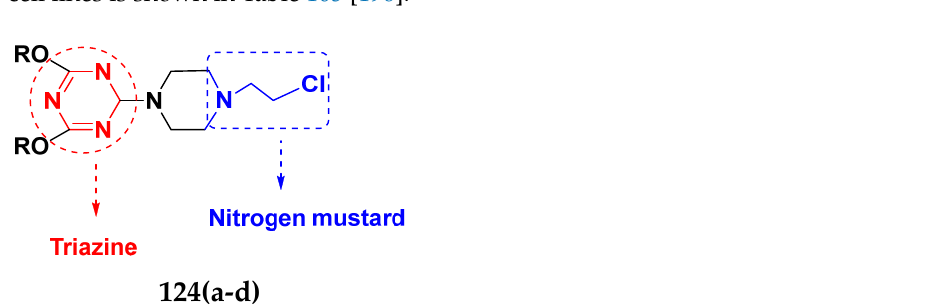
Figure 118. Structure of nitrogen mustard ‐ containing triazine derivatives 124 ( a – d ). Table 105. In vitro cytotoxic activities of nitrogen mustard ‐ containing triazine hybrid compounds 124 ( a – d ).